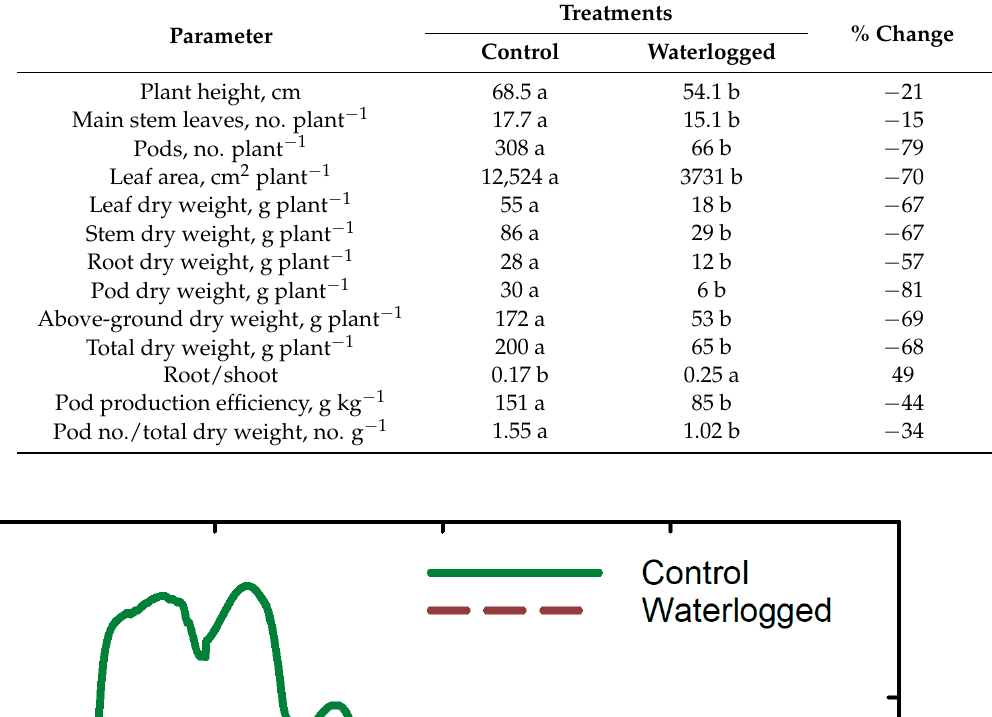
Table 3. Effects of waterlogging on soybean growth, development, and reproductive traits; mea- surements were taken 66 days after sowing. The lowercase letters indicate a significant difference at p < 0.05.